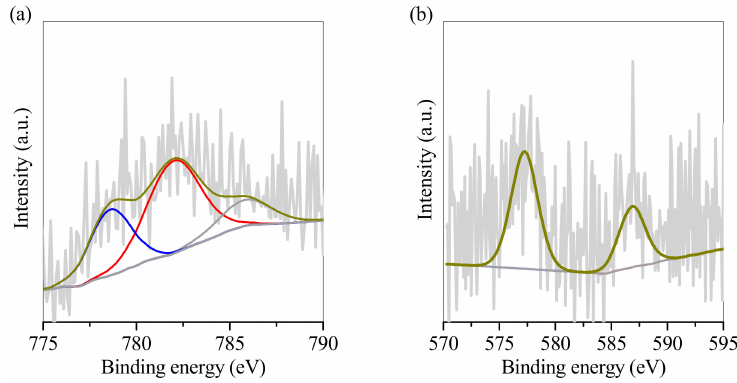
Figure 13. High resolution ( a ) Co 2p, ( b ) Cr 2p XPS spectrum of SP1 and SP2 after smelting wastewater